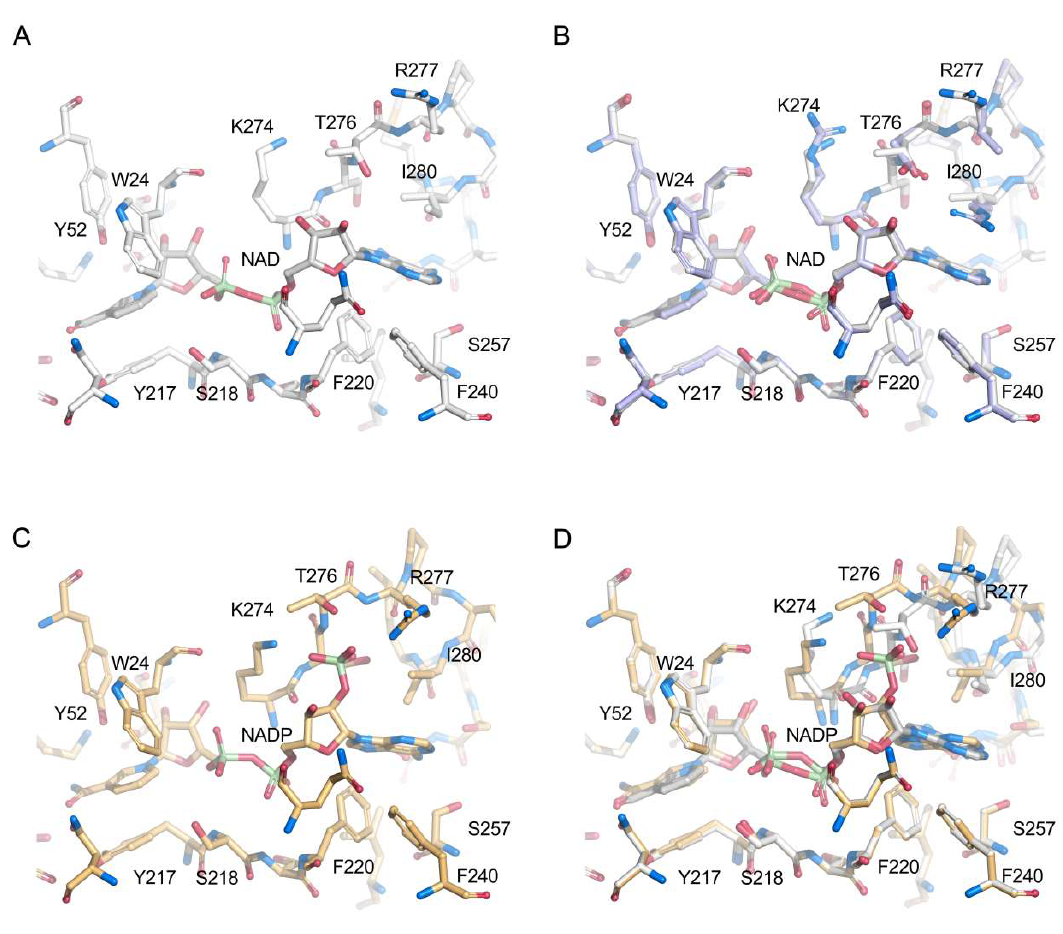
Figure 9. Representation of the modeled cofactor-binding site in Ct XR. ( A ) Details of the Ct XR-NAD homology model (gray). ( B ) Overlay of the Ct XR homology model (gray) and the Ca XR crystal structure (light blue). ( C ) Details of the Ct XR-NADP homology model (orange). ( D ) Overlay of the Ct XR-NAD (gray) and Ct XR-NADP (orange) homology models. All side-chain notations are according to the Ct XR